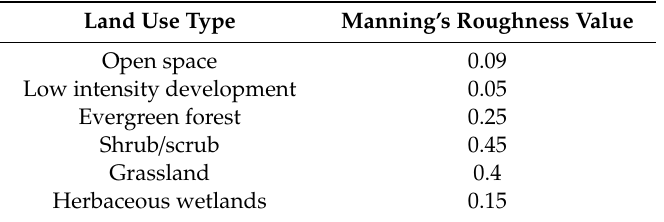
Table 2. The Manning’s roughness parameter values for the routing model.